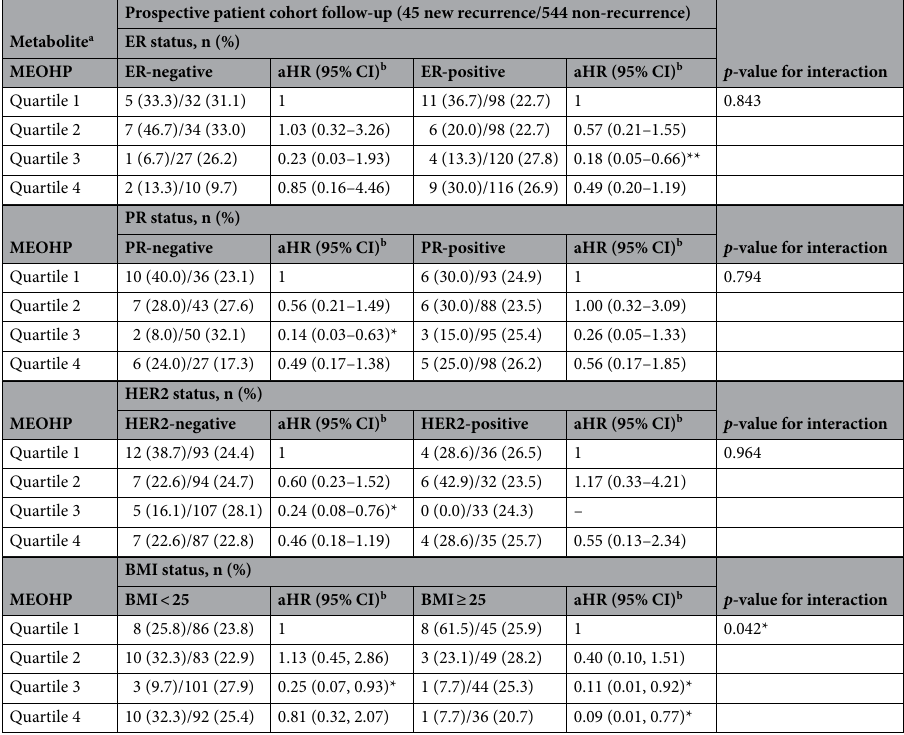
Table 3. The interaction between MEOHP and hormone receptors as well as BMI on recurrent breast cancer in prospective follow-up (figure as shown in Supplementary Fig. S1). HR hazard ratio, CI confidence interval. a The urinary concentration unit of phthalate metabolites were μg/g creatinine and were categorized into quartiles with the first quartile being defined as the reference group. b HR was calculated by multivariable Cox proportional hazards model and adjusted for marriage and radiotherapy, shown as aHR (95% CI). * p- values < 0.05, ** p- values <